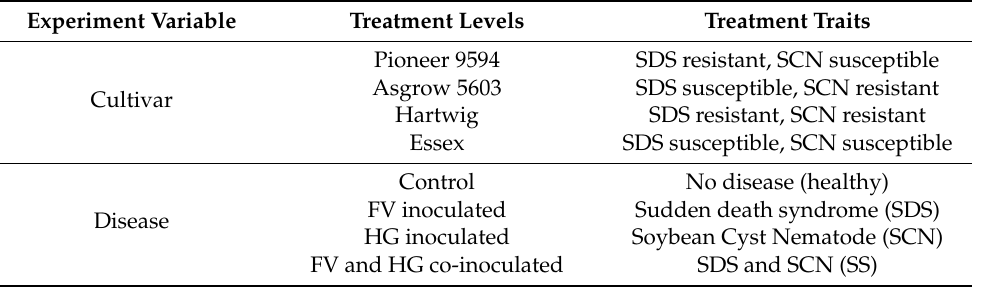
Table 1. Details of experimental design used in the field study with four cultivars and four disease treatments. The four disease treatment included combinations of two pathogens, sudden death syndrome (SDS) caused by F. virguliforme (FV) and soybean cyst nematode (SCN) caused by H. glycines (HG), both (SS), or neither (Control or healthy). All treatment combinations were replicated five